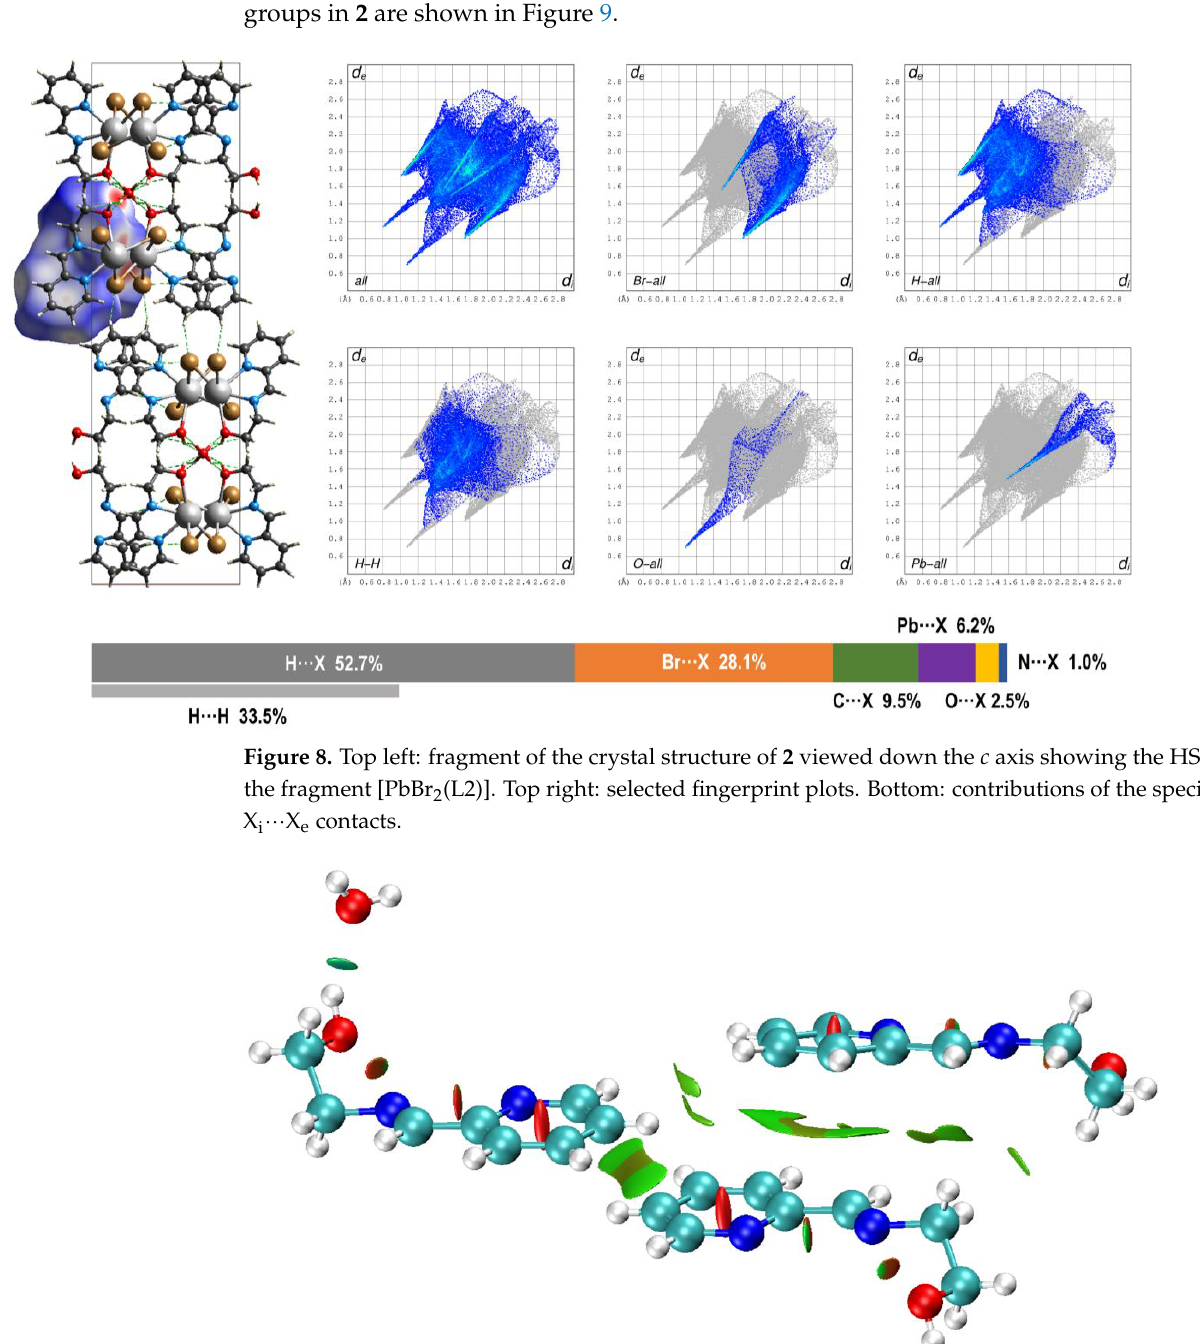
Figure 9. Reduced density gradient surfaces (isovalue of 0.5) showing vdW interactions (green area) between aromatic fragments and strong hydrogen bonds involving water molecule for compound 2 .